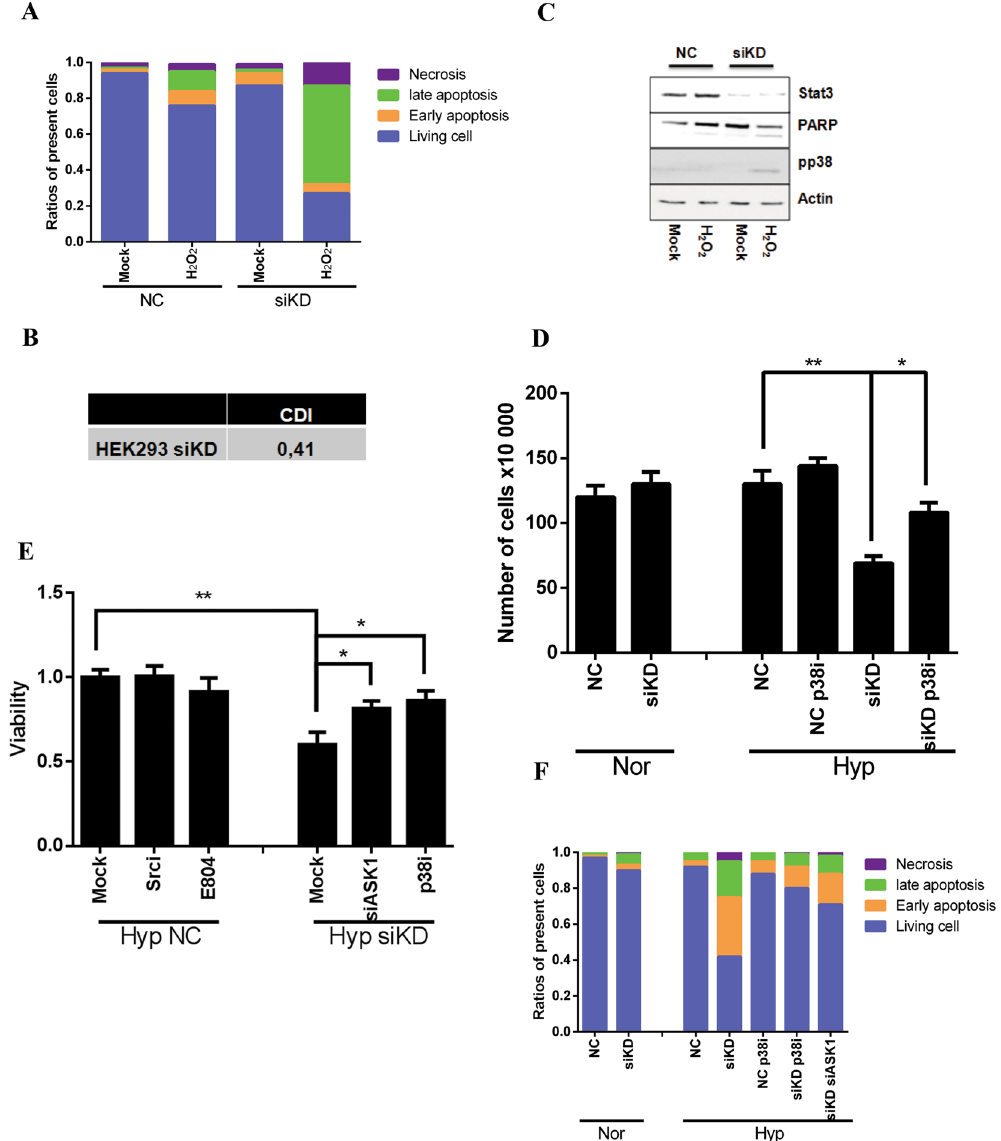
Figure 4. The synergestic effect is reproducible in Stat3-deficient HEK293 cells and in HeLa KD cells under hypoxia. ( A ) Enhanced apoptotic effect was observed in HEK293 transfected with Stat3 siRNA. Cells were treated with H 2 O 2 for 24 hrs and analyzed by apoptosis assay. Apoptosis assays were performed following treatment. ( B ) Coefficient of drug interaction. ( C) Stat3 deficiency contributed to hyperactive phosphorylation of p38 MAPK in the presence of H 2 O 2 . Cells were treated with 1 mM H2O2 for 1 hr. The whole cell lysate was subjected to immunoblotting. ( D ) Cells were counted after 24 hrs treatment with or without p38i in HeLa siKD cells under normoxic or hypoxic using trypan blue assay. Nor: normoxia; Hyp: hypoxia. ( E ) MTT assay was performed to evaluate the anti-proliferative effect of small molecules (p38i) or ASK siRNA (siASK) as indicated under hypoxia in HeLa siKD cells. ( F ) The influence of p38i and siASK on cell apoptosis under hypoxia was measured by annexin v/PI assay. ( ** p < 0.01; * p <